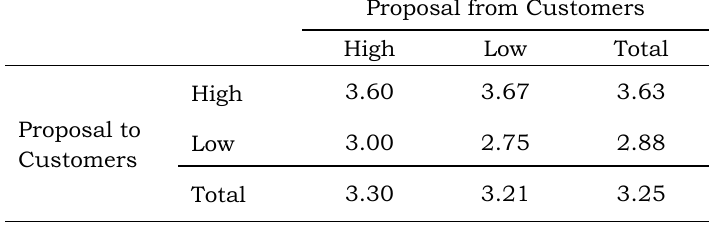
Table 4. Average return on sales of low DC